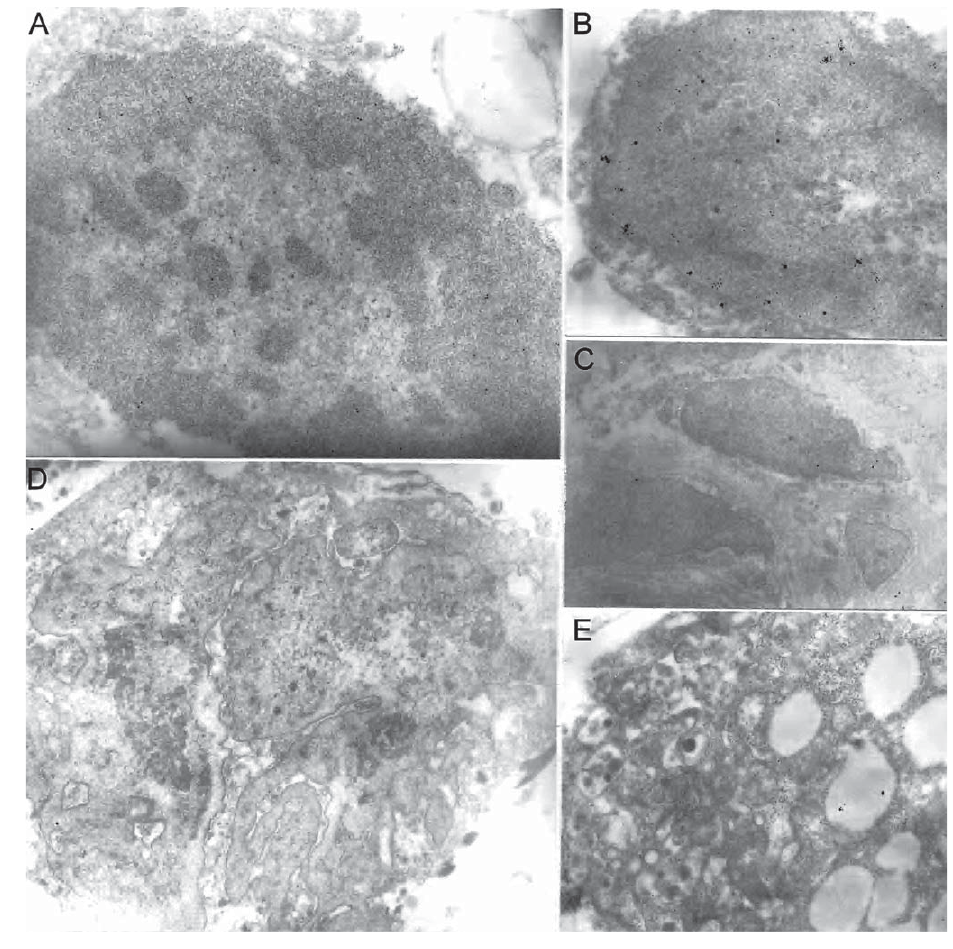
Fig. 7. Low immunoreactivity either for WOX1 (10nm particles) or merlin (20nm particles) in transition meningiomas as shown by electron